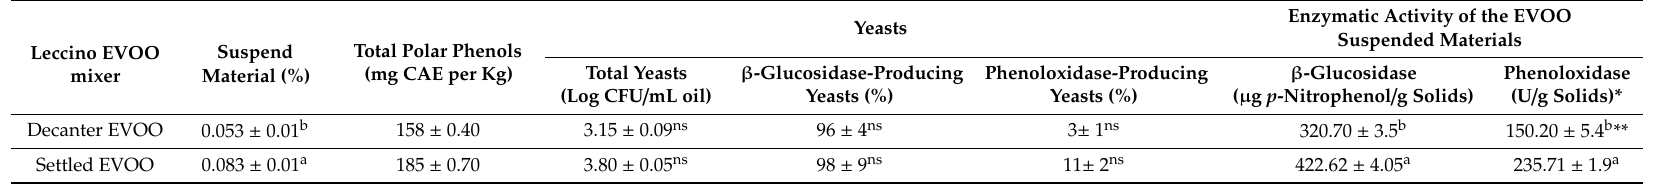
Table 2. Microbiological and enzymatic characteristics of the mixer Leccino EVOO used to blend with Don Carlo EVOO.